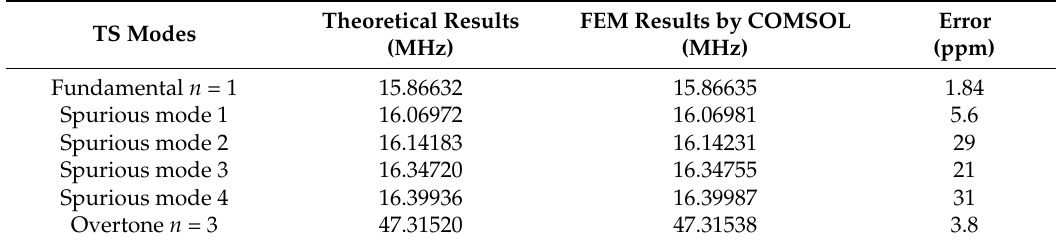
Table 2. Comparison of TS mode frequencies obtained by theoretical analysis and FEM simulation. TS Modes Theoretical Results (MHz) FEM Results by COMSOL (MHz) Error (ppm) Fundamental n = 1 15.86632 15.86635 1.84 Spurious mode 1 16.06972 16.06981 5.6 Spurious mode 2 16.14183 16.14231 29 Spurious mode 3 16.34720 16.34755 21 Spurious mode 4 16.39936 16.39987 31 Overtone n = 3 47.31520 47.31538